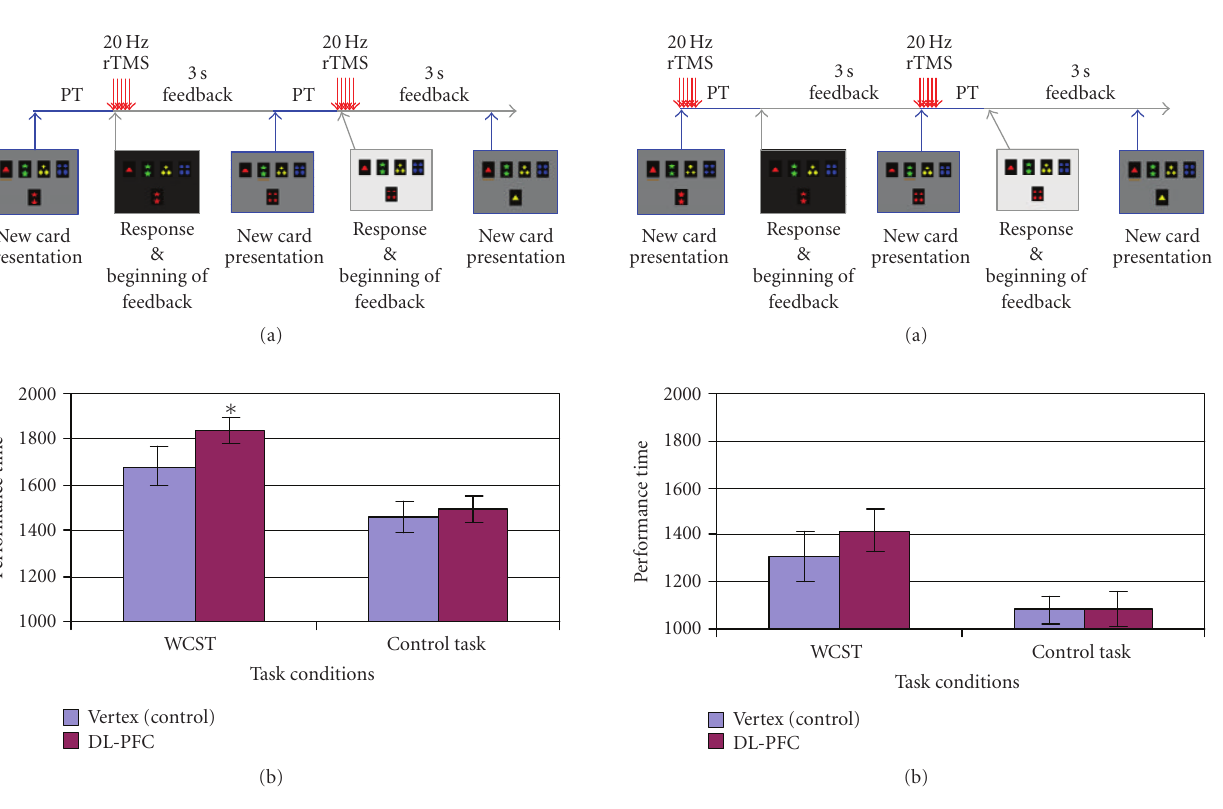
Figure 4: (a) rTMS at the beginning of feedback: while the subject performed the WCST or control task, rTMS was applied over the right DL-PFC or vertex at the beginning of receiving feedback. (b) DL-PFC stimulation during the feedback phase of the WCST in- creased performance time (PT) compared to the vertex stimulation ( ∗ P = .023; two-tailed). No stimulation e ff ect was observed in the control task.